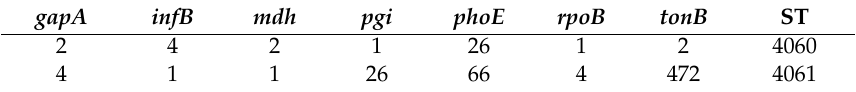
Table 2. Allelic profiles for novel K. pneumoniae sequence types ST4060 and ST4061.